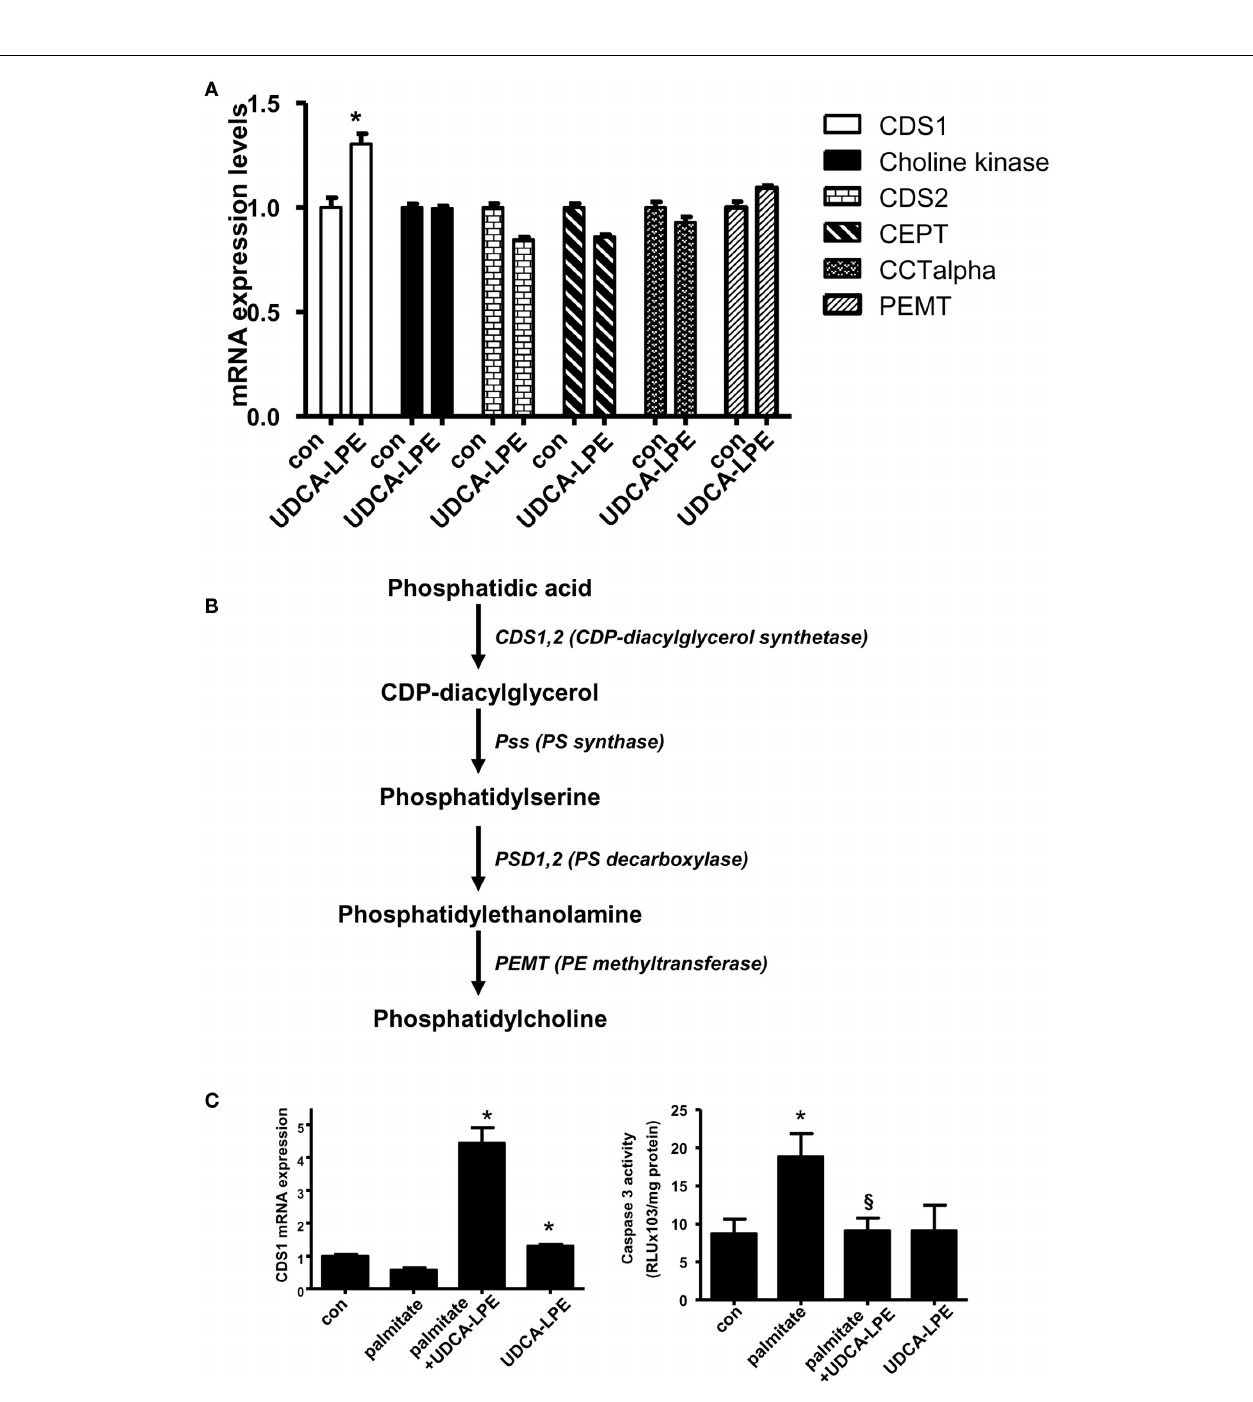
FIGURE 3 | Ursodeoxycholyl lysophosphatidylethanolamide upregulated CDS1 gene concomitant with inhibition of apoptosis induced by palmitate. (A) Treatment of mouse hepatocytes with 60 μ M UDCA-LPE for 20h increased expression of CDS1 but failed to increase other PC synthesis genes including choline kinase, CDS2, CEPT2, CEPT, CCTalpha, and PEMT. Quantitative RT-PCR was performed byTaqMan® RT-PCR with relative expression ( Δ Rn ) of the target gene versus GAPDH mRNA. Data were representative data obtained from two different experiments. Data were mean ± SD, N = 4; * p < 0.05 versus con. (B) A scheme demonstrates metabolism of